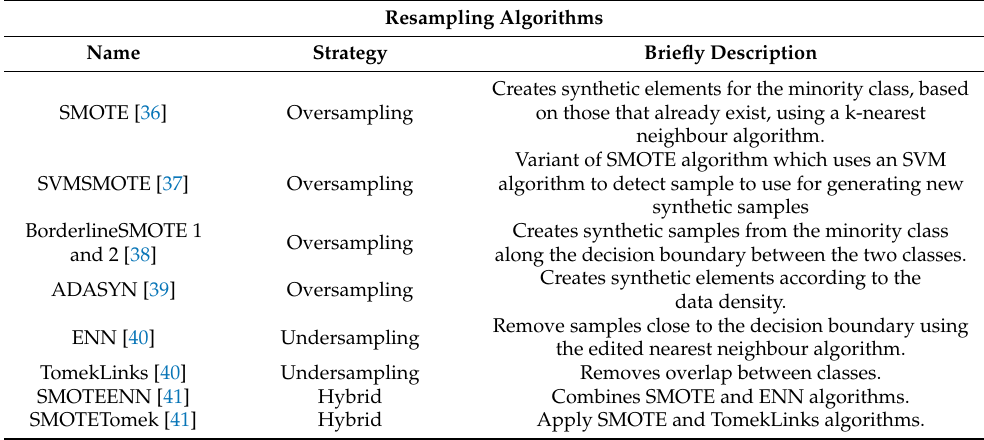
Table 1. Summary of classic binary resampling